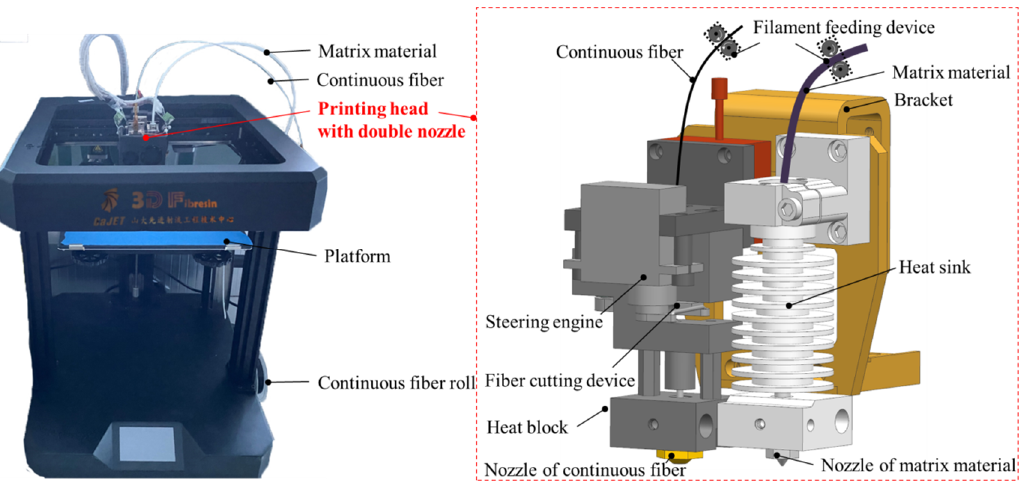
Figure 1. FDM 3D printer with double-nozzle structure for printing fiber-reinforced PEEK composites: ( left ) FDM 3D printer for short- and continuous-fiber-reinforced PEEK composites; ( right ) printing head with double-nozzle structure.